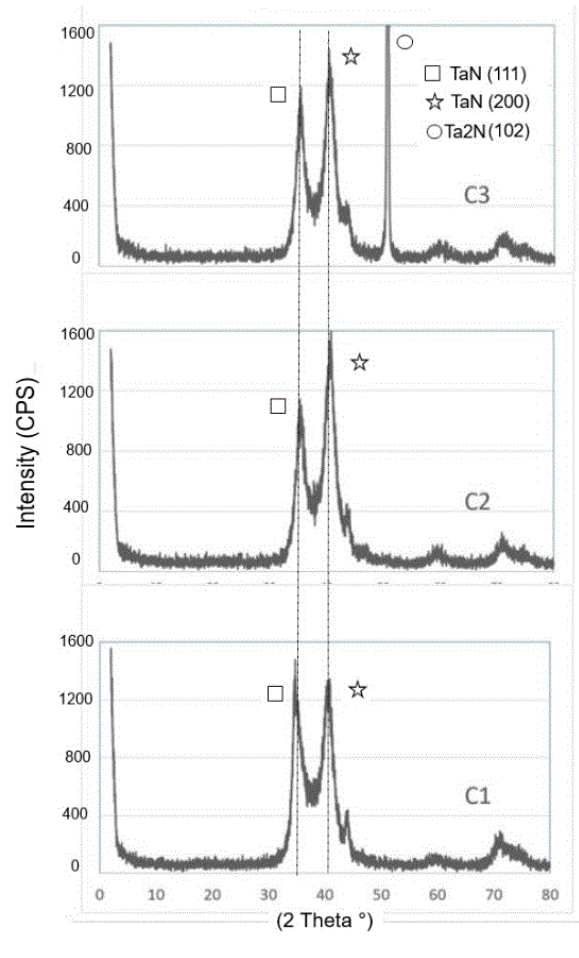
Figure 4: Xrd patterns of the coatings